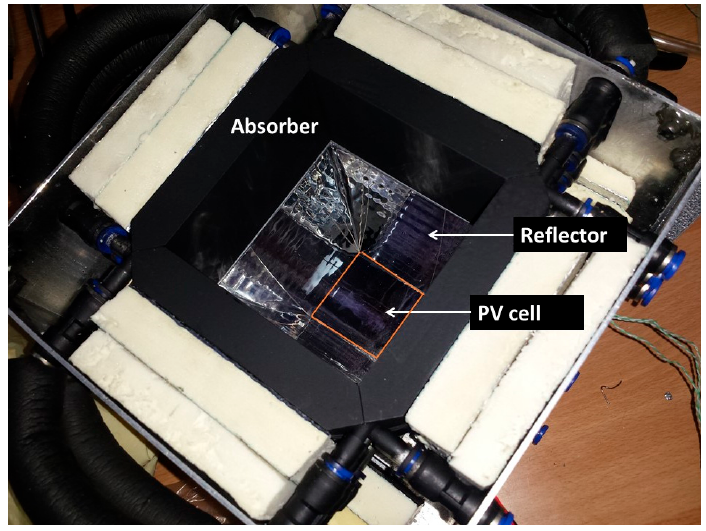
Figure 5. Inside view of the assembled module. Note the insulations around the absorber.